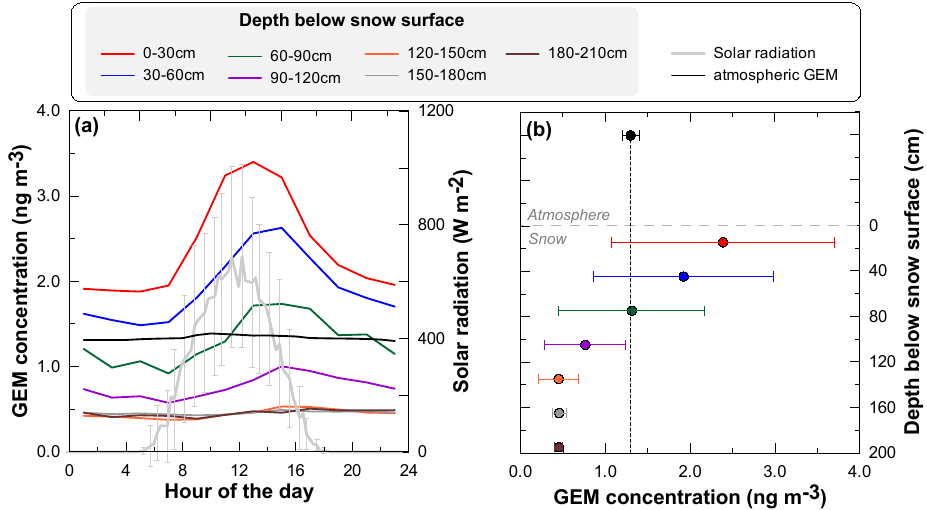
Fig. 2. Snow air GEM data from DOY 37 to 122, 2009, combined into 30cm depth intervals down from the top of the snowpack. (a) Diurnal evolution and averaged incoming solar radiation in the depth profile. (b) Averaged vertical patterns and standard deviation for the respective depth layers. The dashed vertical line shows the mean ambient atmospheric GEM